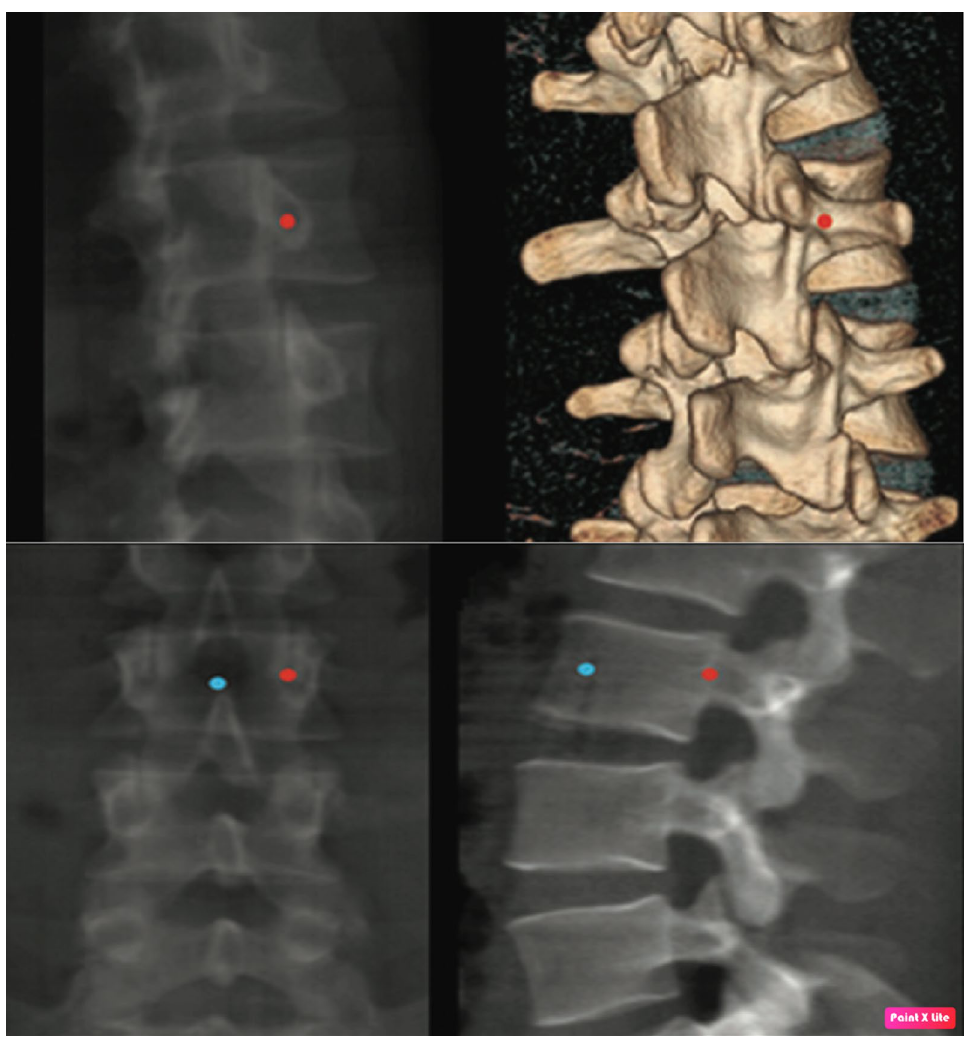
Fig. 7 Fluoroscopic view for transpedicular access to the vertebral body. Upper views show the target point “red dot” at the centre of the “Scottie Dog” eye. Lower views Identify the safe margins during insertion of the needle. During pedicle trajectory, the medial cortex of the pedicle is considered the safe medial limit on AP view (red dot in lower left view) until the posterior vertebral wall is passed on the lateral view (red dot in the lower right view). Inside the body, the needle can be advanced towards the midline in AP view (blue dot in lower left view) and the safe limit is the junction between the anterior and middle thirds of the vertebral body in lateral view (blue dot in lower right view). (Reproduced from